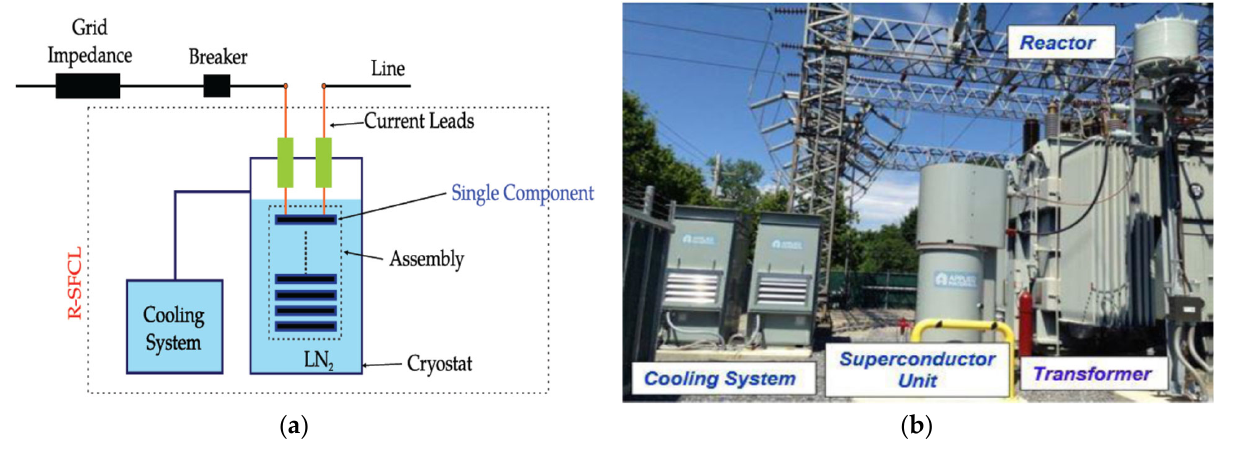
Figure 1. ( a ) The schematic of a RSFCL [29]; ( b ) a practical installation of SFCL [30].